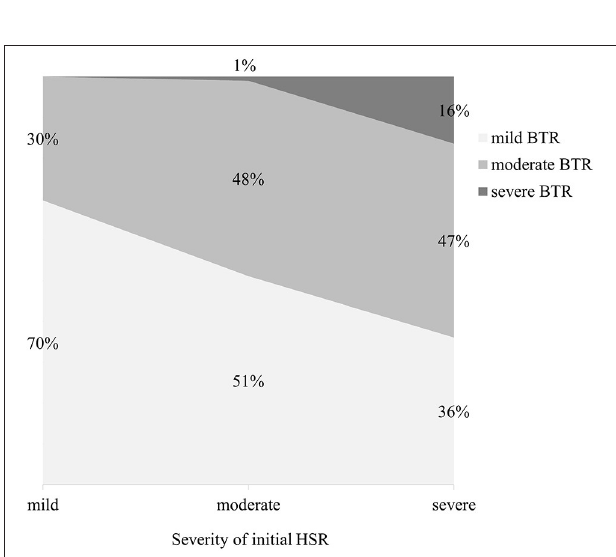
FIGURE 2 | The severity of BTRs reactions according to that of initial HSRs. HSR, hypersensitivity reaction; BTR, breakthrough reaction.